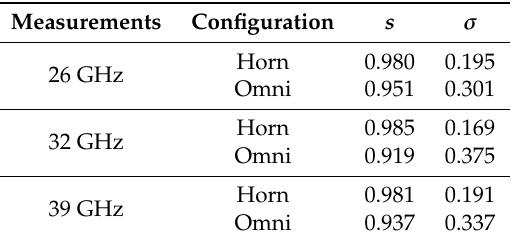
Table 5. Ricean distribution